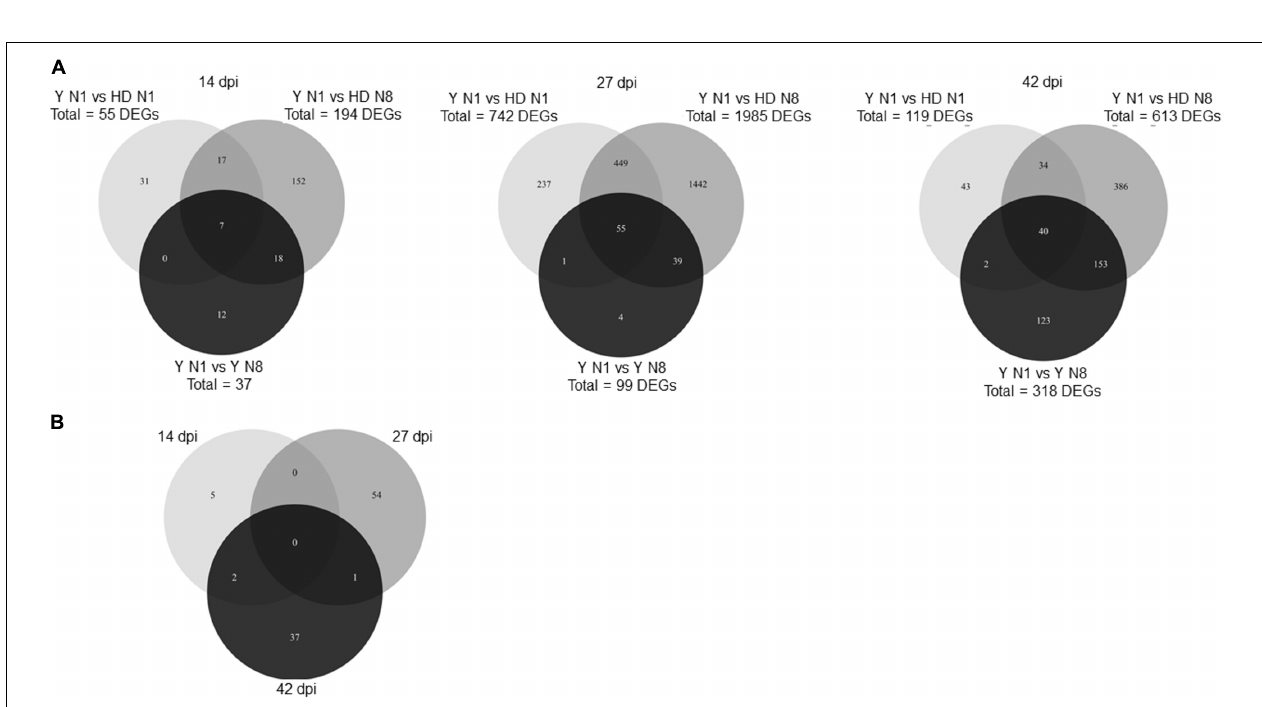
FIGURE 6 | Number of Plasmodiophora brassicae DEGs between Y N1 and each of the other three conditions. (A) The Venn diagrams show the number of significantly DEGs ( P < 0.05) between Y N1 and Y N8, or HD N1, HD N8 at each sampling date. (B) The Venn diagram focuses on the DEGs common between Y N1 and the other three conditions described at each of the three interaction time-course points (i.e., 7 genes at 14 dpi, 55 genes at 27 dpi, and 40 genes at 42 dpi). DEGs, differentially expressed genes; dpi, days post-inoculation; Y, Yudal genotype; HD, HD-018 genotype; N1, 1 mM nitrogen; N8, 8 nitrogen supply.